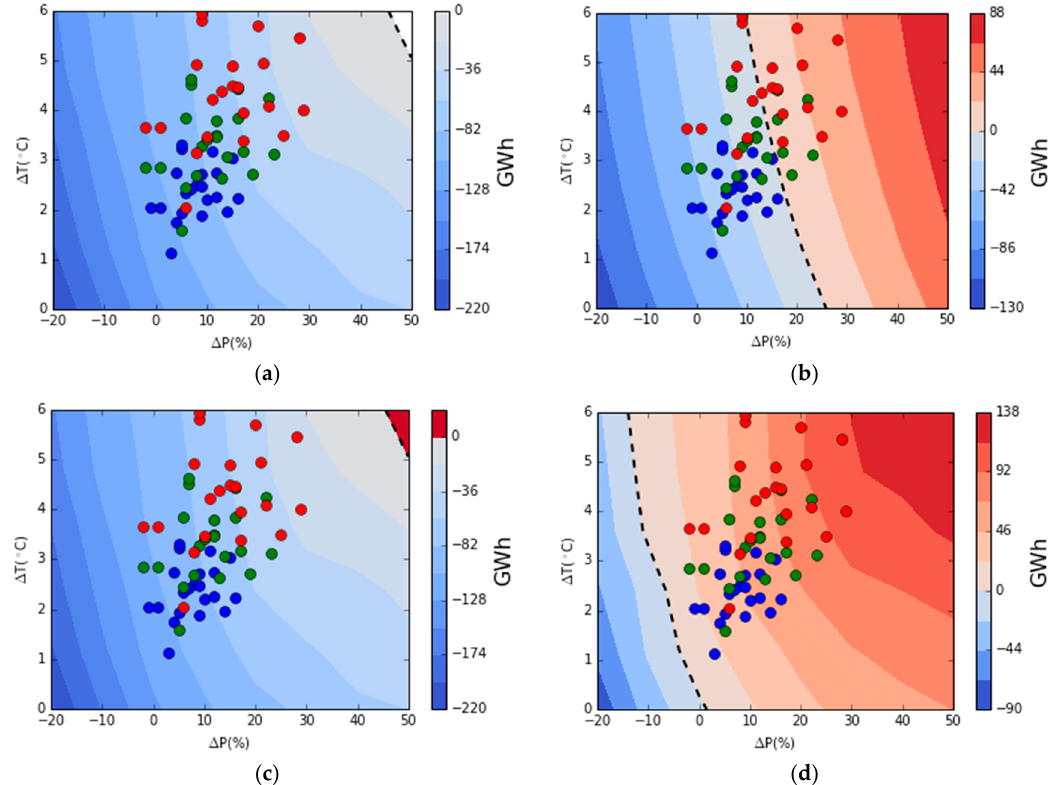
Figure 6. CRFs of the Mid-Norway weekly energy balance (GWh) obtained with the: ( a ) W1G1 scenario for the whole year; ( b ) W2G2 scenario for the whole year; ( c ) W1G1 scenario for the winter season; and ( d ) W2G2 scenario for the winter season. Nil energy balance curves are highlighted with dashed black lines. The coloured dots give temperature and precipitation changes from the 23 considered GCMs and three considered future time period (blue: 2040–2059; green: 2060–2079; and red: 2080–2099).